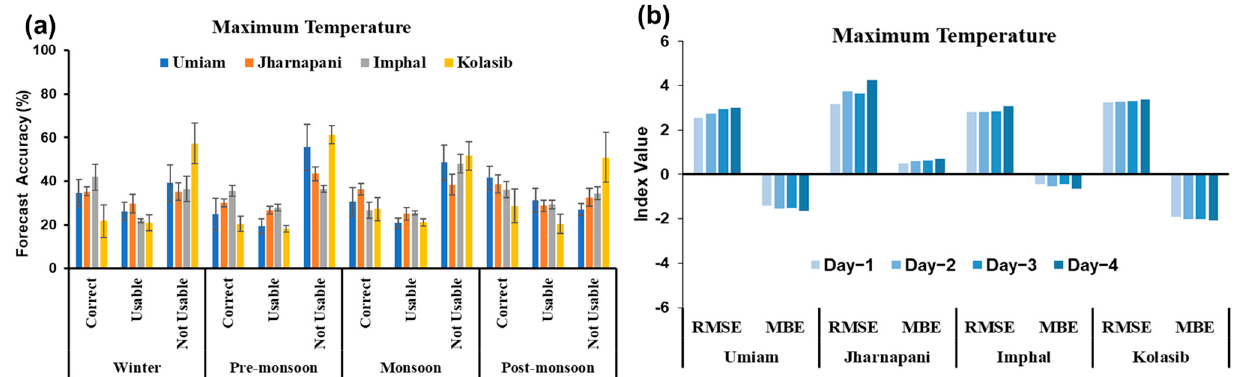
Figure 2. Quantitative ( a ) and statistical evaluation ( b ) of maximum temperature forecast over distinct locations of the northeastern hill region of India. Table 3. Correlation coefficient between the forecasted and observed weather parameters over various locations of the northeastern hill region of India.